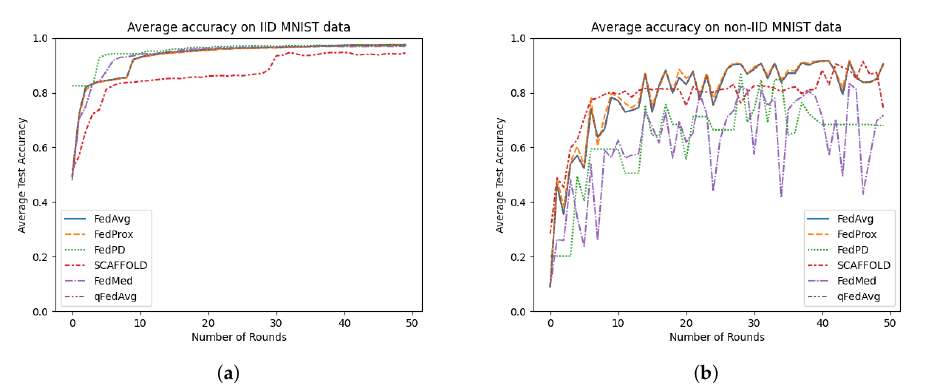
Figure 1. Average accuracy of FL algorithms over ( a ) IID and ( b ) non-IID data distribution for MNIST data